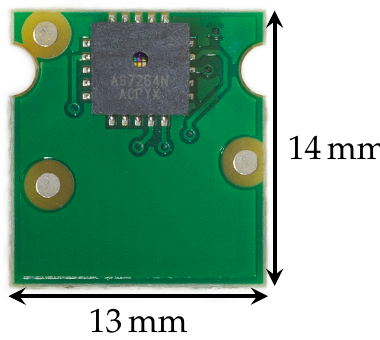
Figure 1. Three-channel true color sensor on a circuit board with rear contacting and milled holes for mounting. The sensor’s surface with its distinct channels can be spotted through the circular opening in the